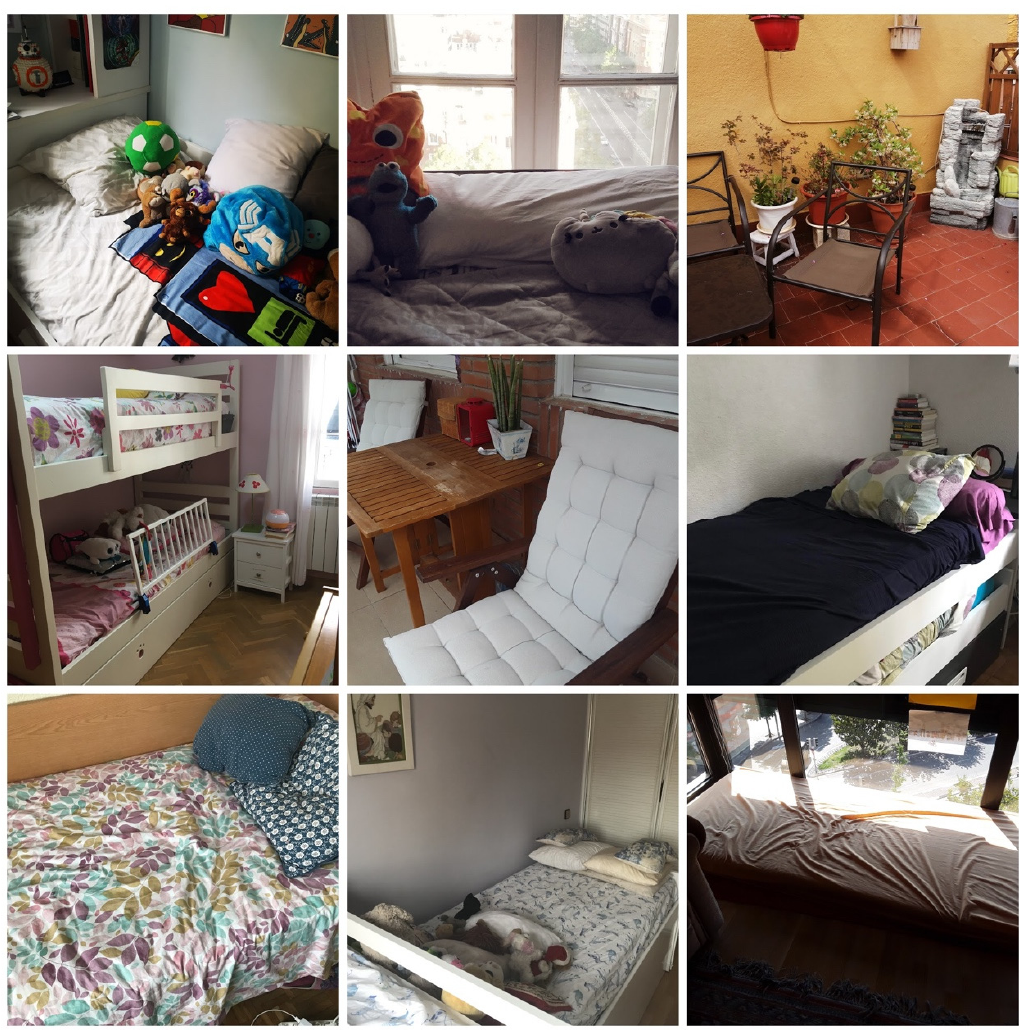
Figure 4. Comfortable spaces, referring to bedrooms, beds, and outdoor spaces.